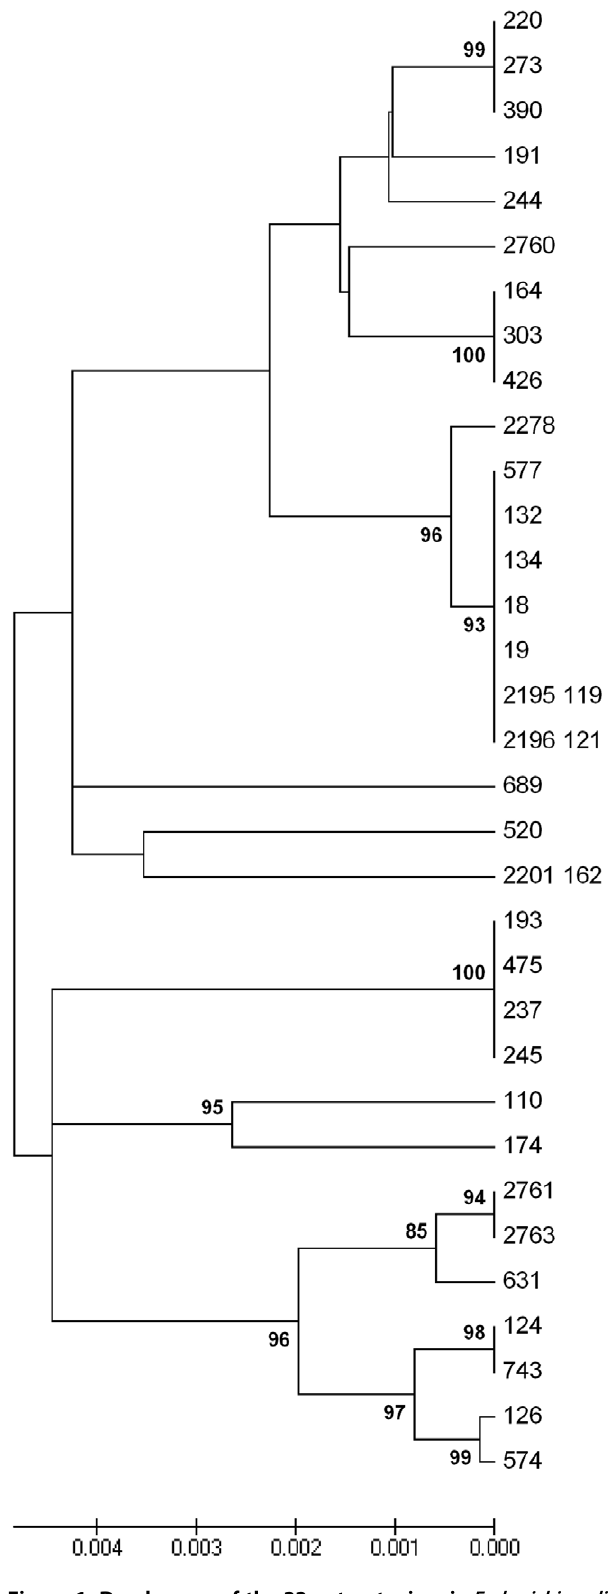
Figure 1. Dendogram of the 33 enterotoxigenic Escherichiacoli strains from Bolivia included in the study.